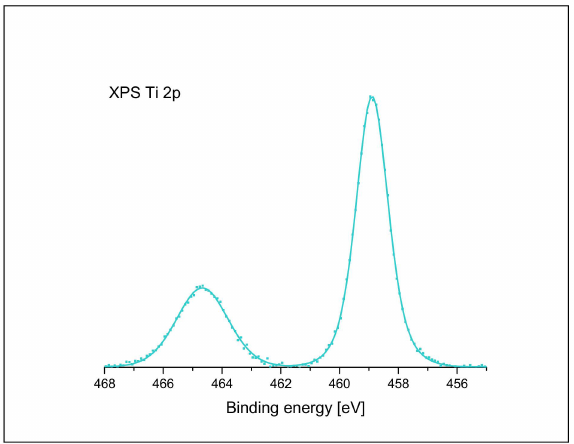
Figure 7. X-ray photoelectron spectrum of Ti 2p transition for TiO 2 /rGO-8-900